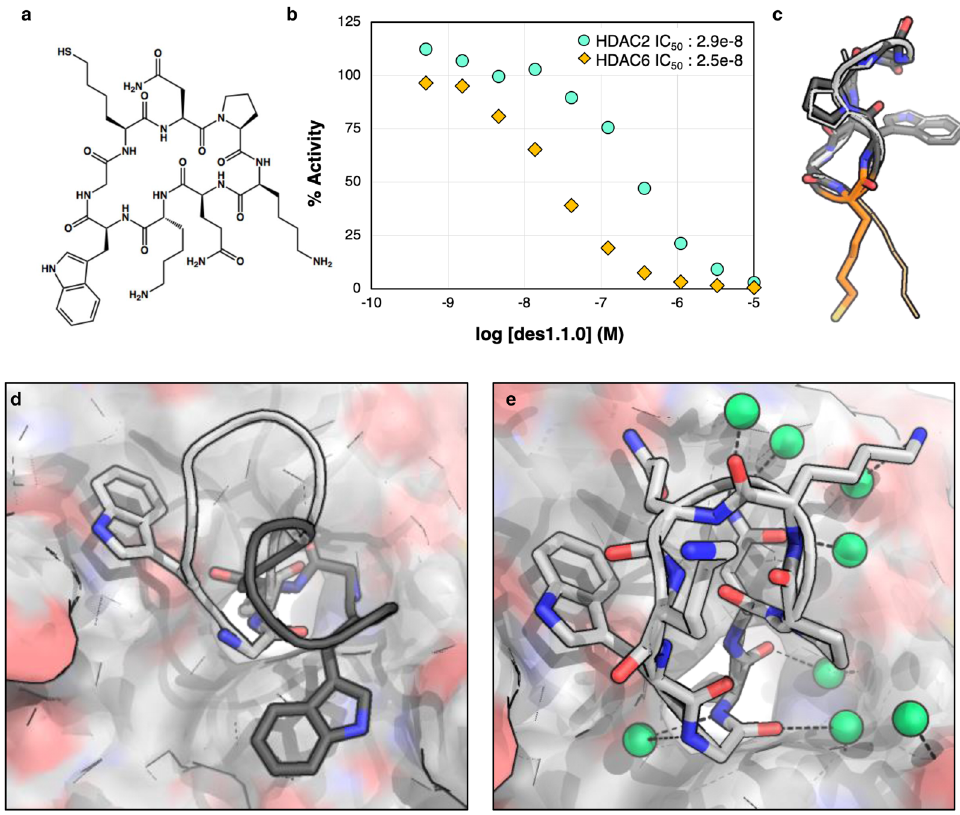
Fig. 2 Crystal structure of des1.1.0 has the designed monomer structure but adopts a different binding orientation. a Chemical structure of des1.1.0. b des1.1.0 inhibits HDAC2 with an IC 50 of 289 nM (Source Data are provided as a Source Data fi le). c Overlay of the designed peptide model des1.1.0 (dark gray) with the crystal structure (light gray). Some sidechains are removed for clarity. SHA anchor is shown in orange. d Overlay of des1.1.0 binding mode in original computational design (dark gray) and crystal structure (light gray) shows a clear rotation around SHA — Zn 2 + axis in the binding pocket. e Crystal structure of des1.1.0 (PDB ID: 6WHO) shows several water-mediated interactions at the interface. Water molecules are shown as green